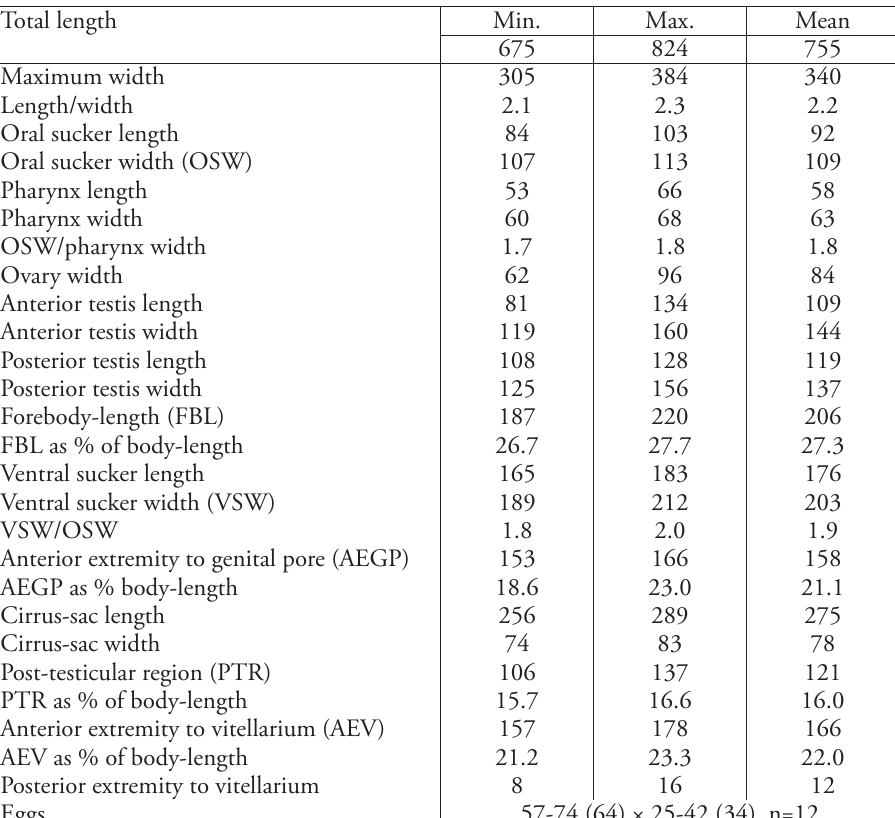
Table 2. Measurements (in μm) of Macvicaria fl exuomeatus n. sp. (n = 3) from Cheilodactylus rubrolabiatus . Total